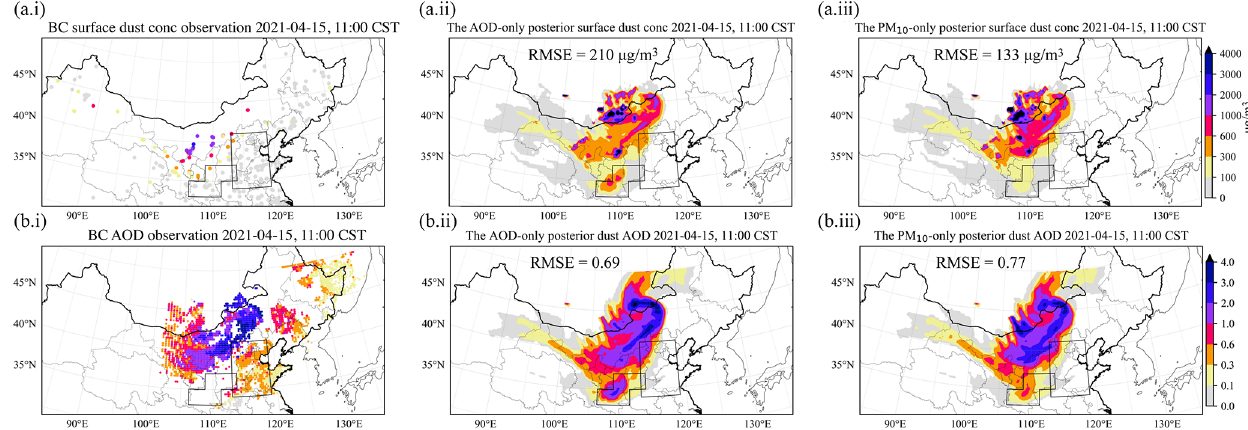
Figure 7. The posterior dust surface dust concentration and AOD simulation either driven by the AOD-only or driven by the PM 10 -only assimilation emission result during SD3. (a.i, b.i) The bias-corrected (BC) PM 10 and AOD observations; (a.ii, b.ii) the dust surface concen- tration and AOD simulation driven by the posterior emission from AOD-only assimilation; (a.iii, b.iii) the dust surface concentration and AOD result driven by the posterior emission from PM 10 -only assimilation at 11:00, 15 April. Table 2. Evaluation (RMSE) of the posterior dust simulation either by assimilating AOD, or by assimilating PM 10 , or by assimilating both of them. Timeline Priori Multi-observation AOD only PM 10 SD1 PM 10 at 10:00, 15 March 833µgm − 3 743µgm −